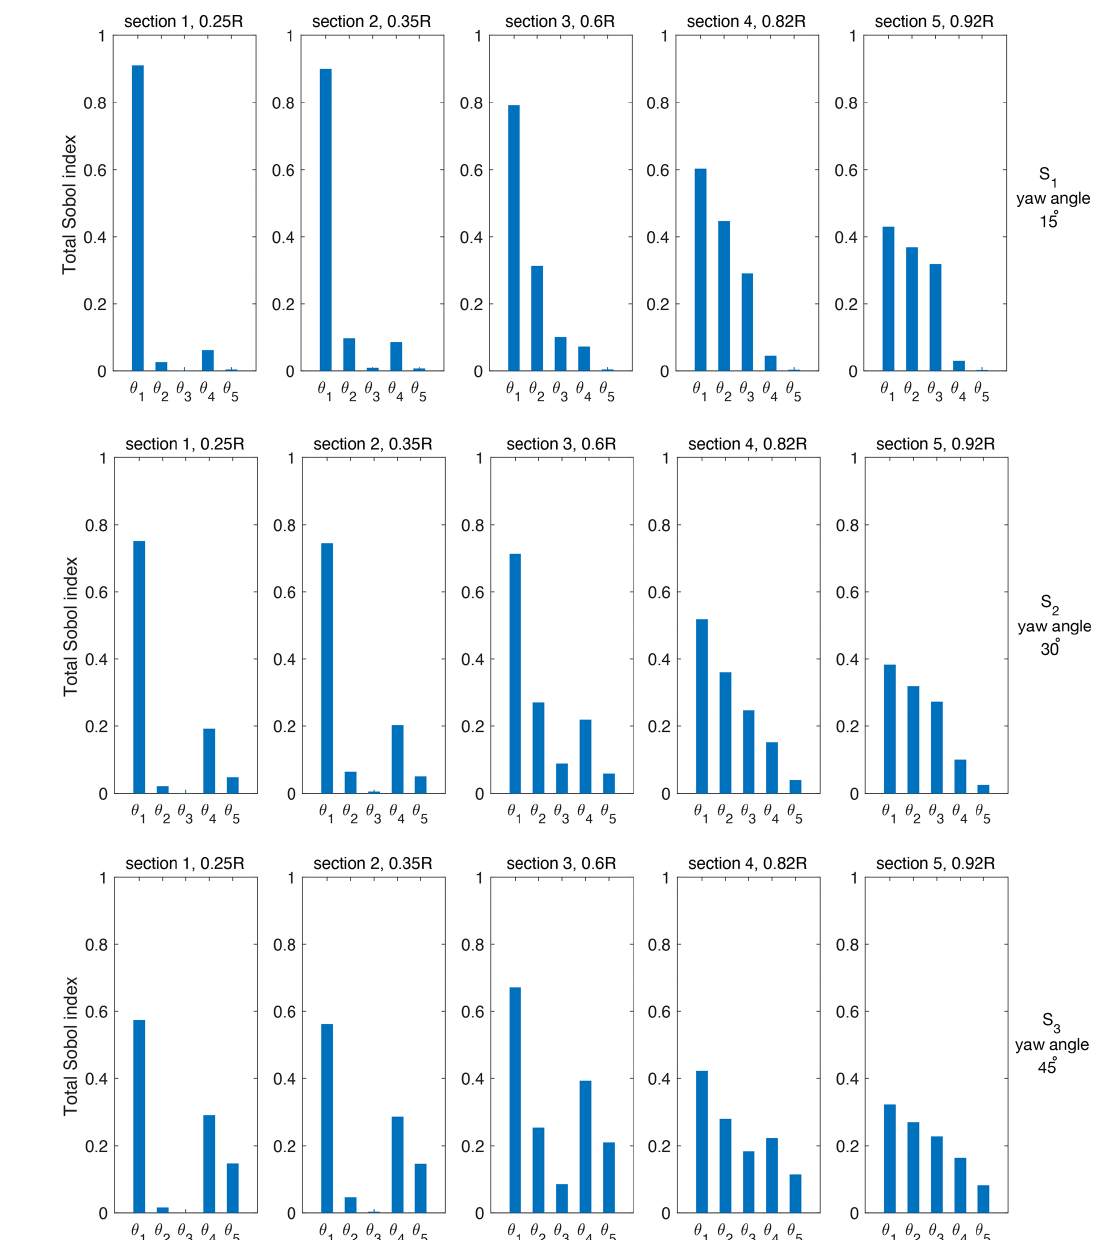
Figure 10. Sensitivity analysis for three different operating conditions: S 1 (top), S 2 (middle), and S 3 (bottom). Here θ M = ( θ 1 ,θ 2 ,θ 3 ,θ 4 ,θ 5 ) = (AM 11 , AM 12 , AM 13 , AM 14 , AM 15